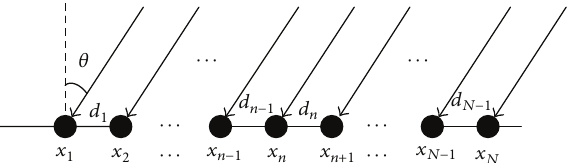
Figure 1: Geometry of the 𝑁 -elements’ unequally linear array placed along the 𝑥